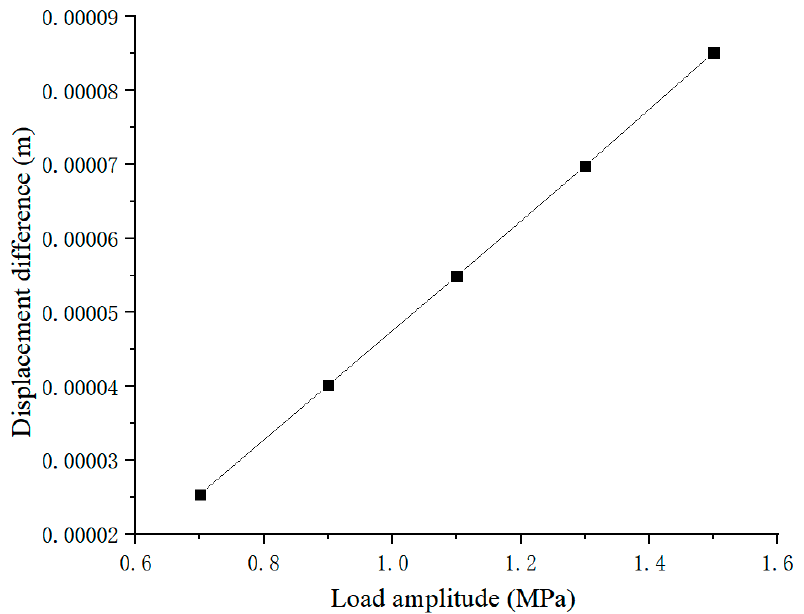
Figure 16. Variation of displacement difference at 14.625 m under different load amplitudes.